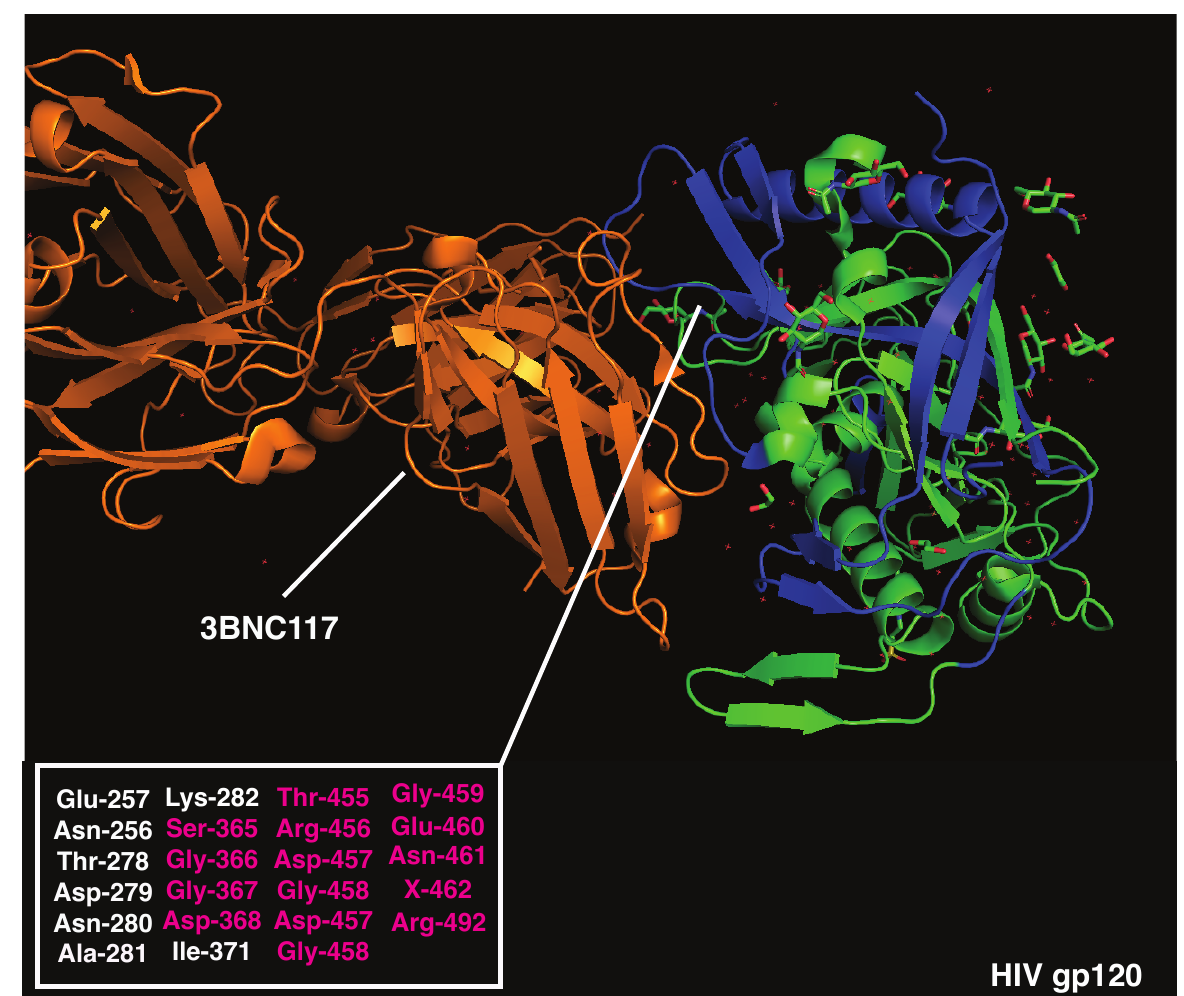
Figure 3. Crystal structure of HIV gp120 monomer and 3BNC117 bnAb (PDB:4JPV). Immunodomi- nant CD4 epitopes are highlighted in blue. Amino acids essential for 3BNC117 binding are listed (bottom left) and those overlapping with CD4-dominant regions are highlighted in